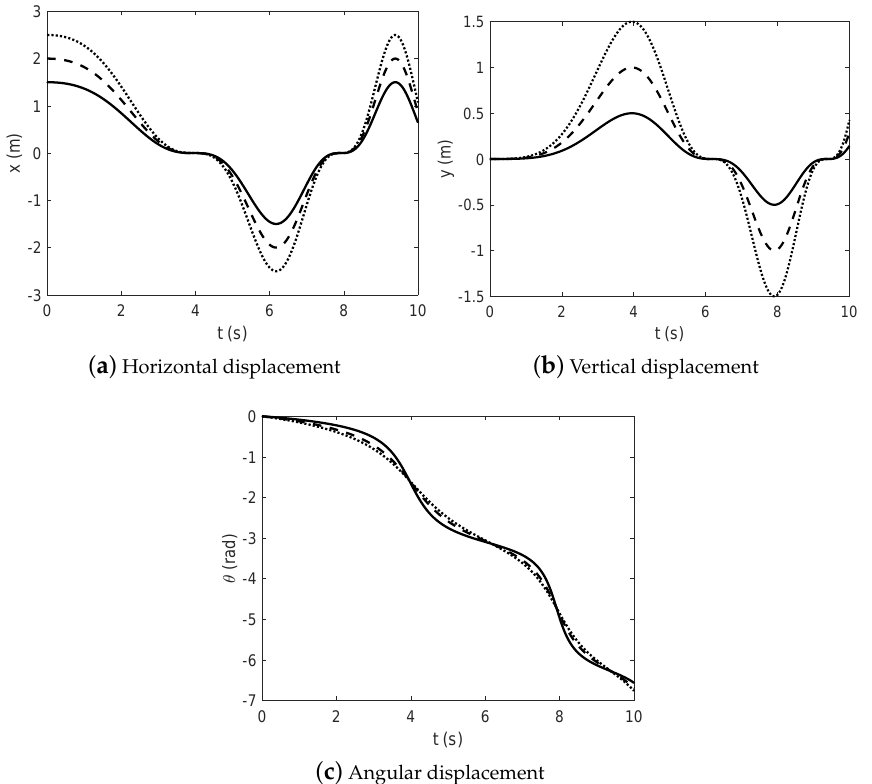
Figure 2. Robot displacement. Initial conditions 1 (solid lines), initial conditions 2 (dashed lines), initial conditions 3 (dotted